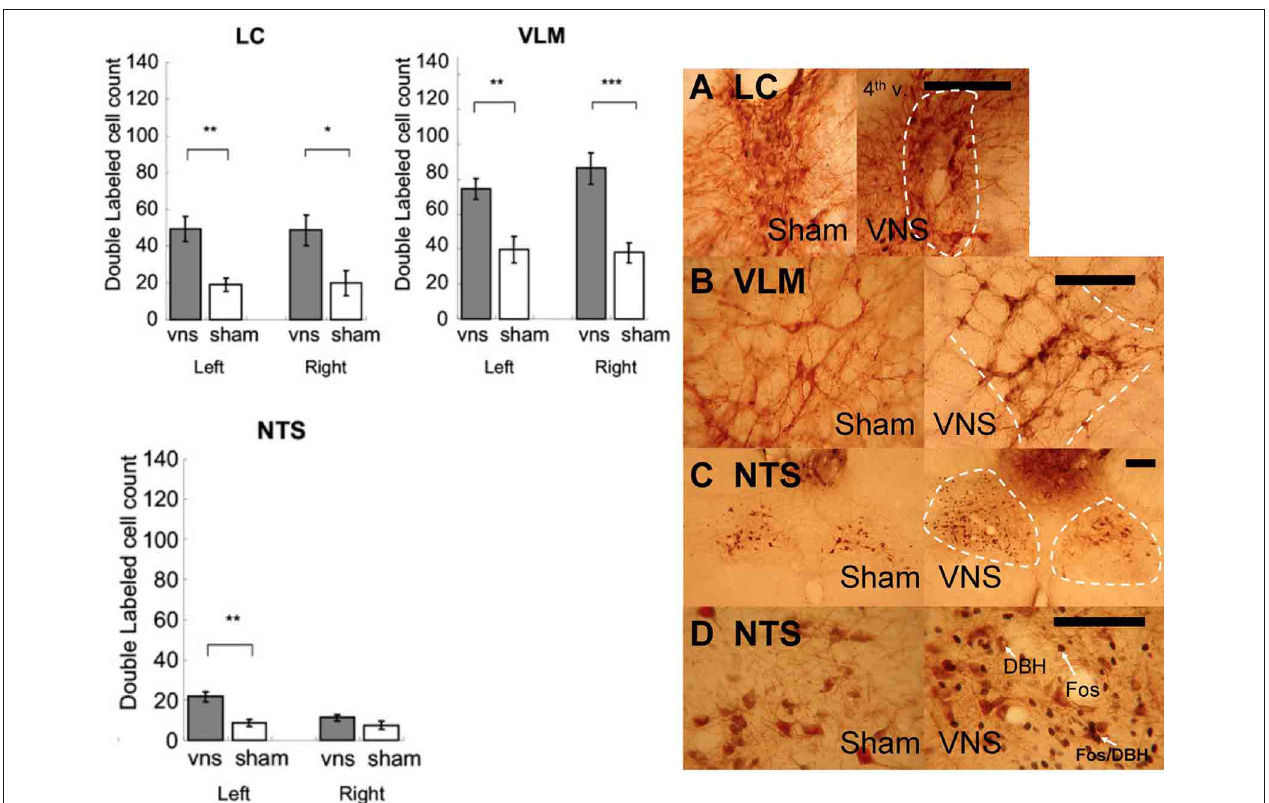
0.05, 0.01, and 0.001, respectively). Photomicrographs of Fos/DBH labeling in the LC (A), VLM (B), NTS (C,D) following sham or vagus nerve stimulation. Scale bar = 200um. (4 th v.: the fourth